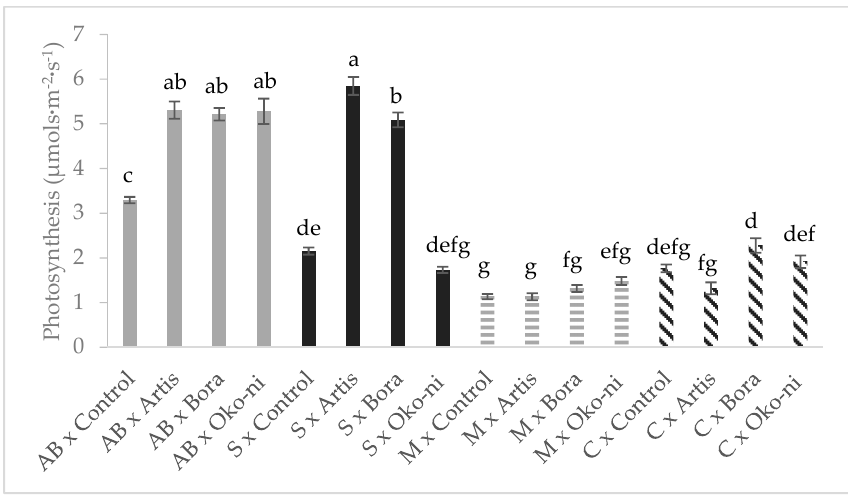
Figure 3. Interaction effects of cultivar and myco-biocontrol formulate on assimilatory pigments of basil. Values with the same lower-case letters are not statistically different at p < 0.05 according to